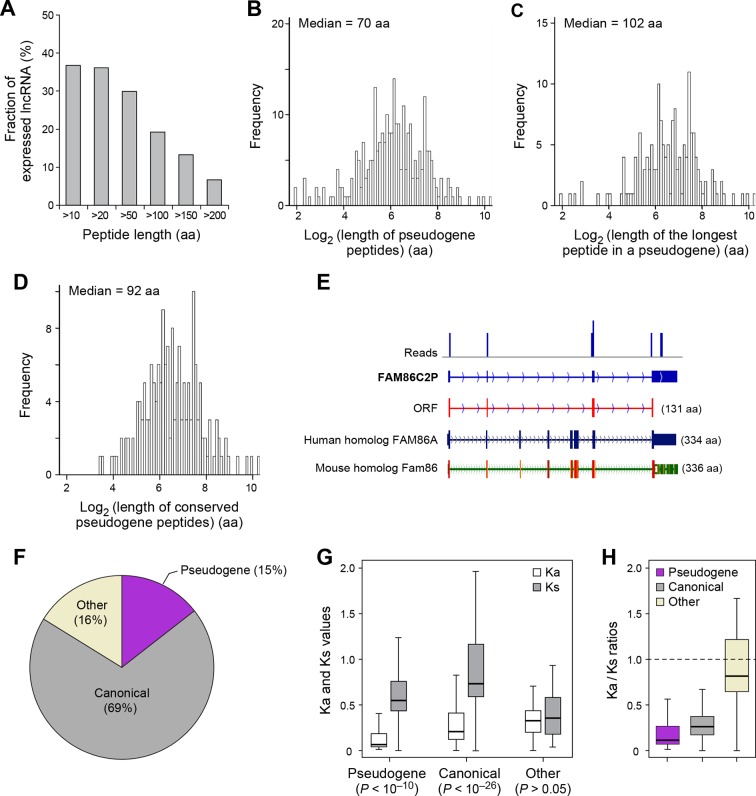
Features and conservation of pseudogene peptides.(A) Fraction of expressed pseudogenes that encode peptides longer than a certain length. (B) Peptide length encoded by pseudogenes. (C) Length of the longest peptides in a given pseudogenes. (D) Length of conserved pseudogene peptides. (E) Peptide in a human pseudogene FAM86C2P is conserved in the mouse protein coding gene Fam86. FAM86C2P also has a homologous human protein coding gene FAM86A. (F) Conserved human pseudogene peptides, grouped based on their homologous ORF types in mouse genome. (G) Ka and Ks values of types of conserved pseudogene peptides with Z-Test p-values shown. (H) Ka/Ks ratios of types of conserved pseudogene peptides.